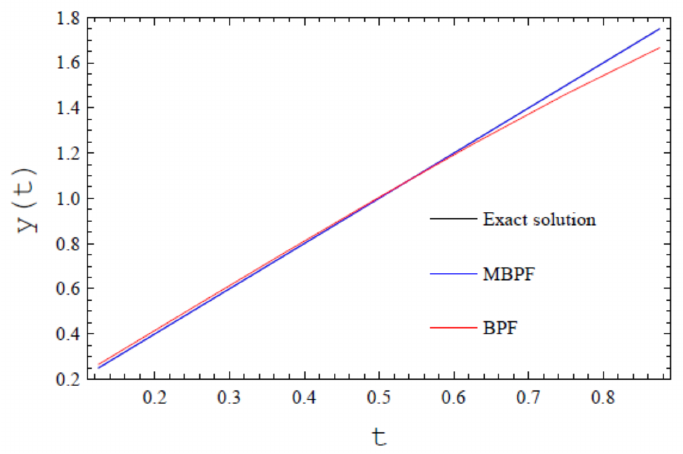
Figure 9. The absolute error of IBPFs and BPFs expansions comparison at the midpoints of the intervals of